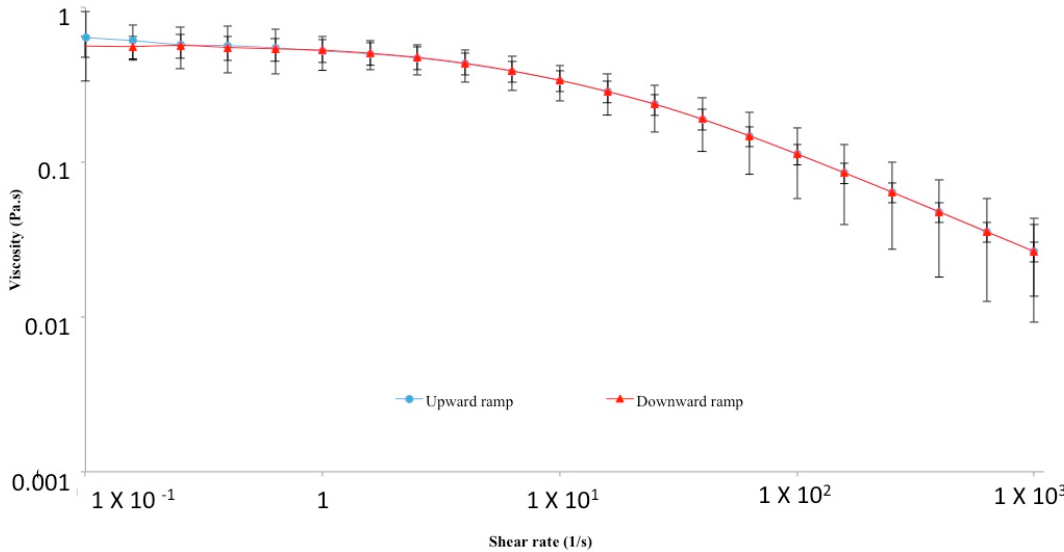
Figure 2. Shear-thinning and non-thixotropic behavior of 0.5% HA solution (2 MDa) analyzed using the rotational rheometer AR2000 (TA instruments, New Castle, DE, USA), connected to the Rheology Advantage software (Version V7.20) and equipped with an aluminum cone/plate geometry (diameter 40 mm, angle 2°, 64-µm truncation). The viscosity decreases in response to gradual increases of the shear rate over time (upward ramp), and then, the viscosity increases in response to gradual decreases of the shear rate over time (downward ramp). The initial viscosity is recovered through the same intermediate states of the breakdown process: the breakdown of the polymeric network is transient and reversible, and therefore, the original structure of HA is recovered.